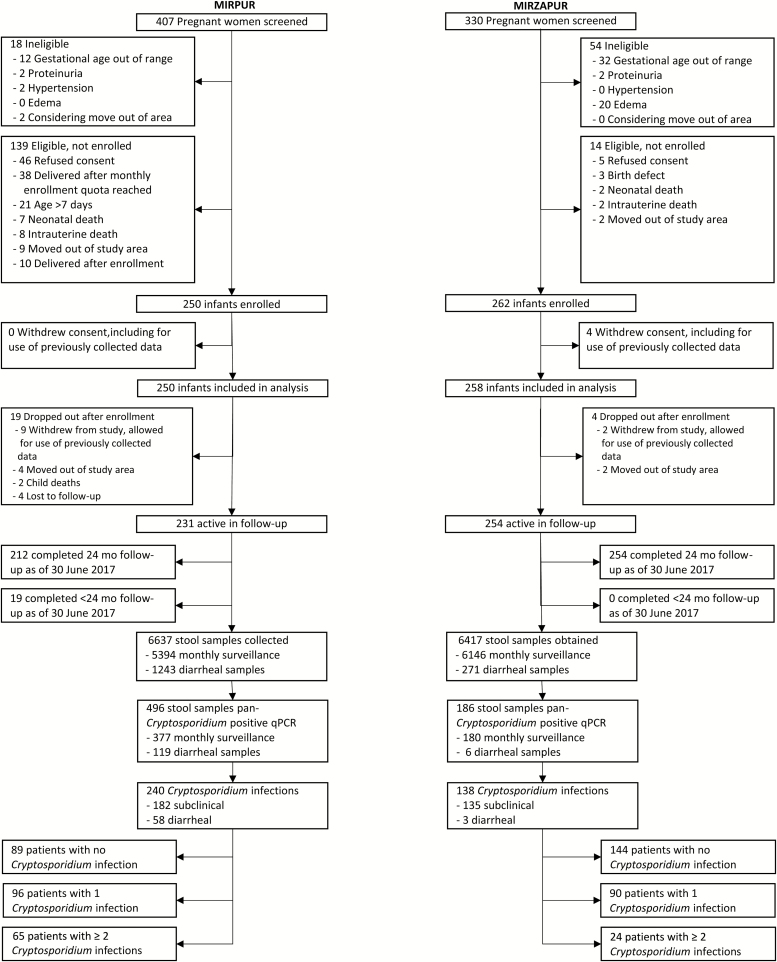
Study flow diagram. Abbreviation: qPCR, quantitative polymerase chain reaction.